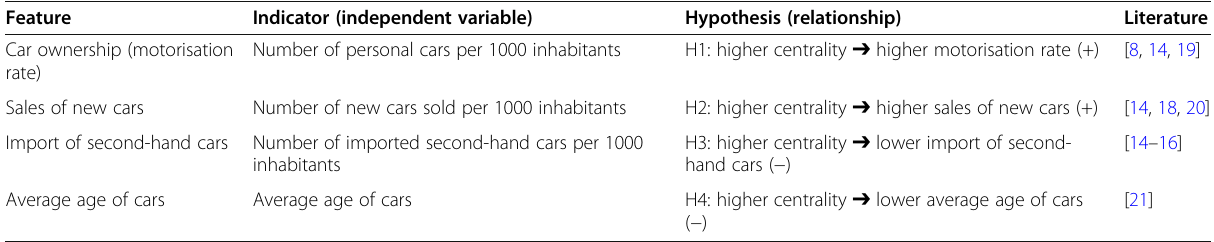
Table 1 Features of the personal car market, their indicators and hypotheses assuming their correlation with the centrality of a given